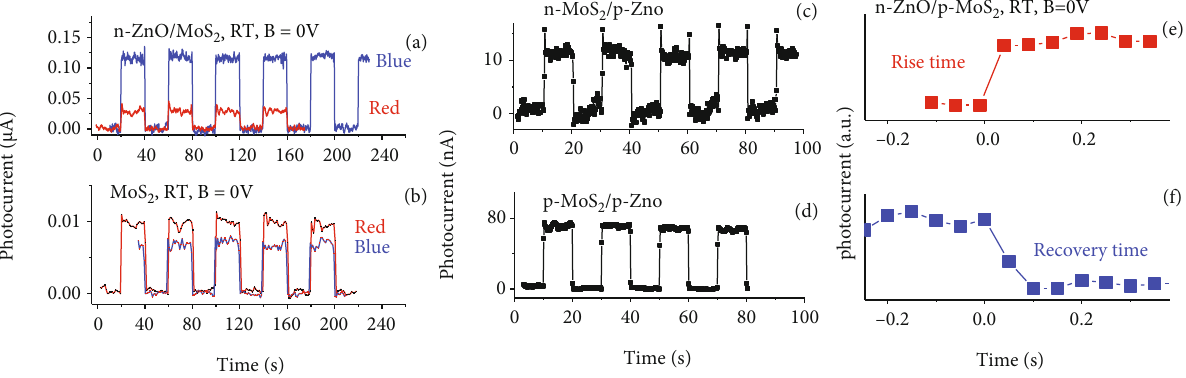
Figure 4: Responses of (a) n -ZnO NW/ p -MoS ZnO NP-based prototypes exposed to light illuminations during cyclic tests in photovoltaic mode and at room temperature. (e, f) Response time and recovery